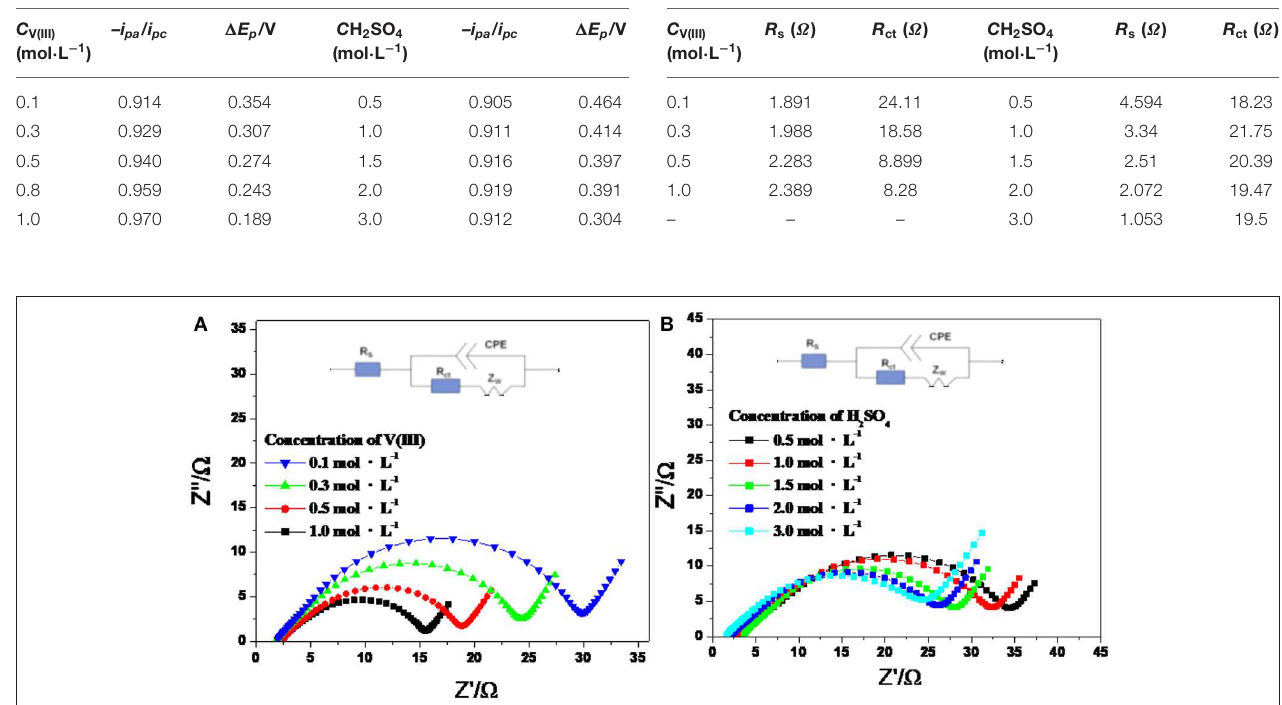
TABLE 2 | EIS parameters obtained by fitting the impedance plots with the equivalent electric circuits in Figure 5 .